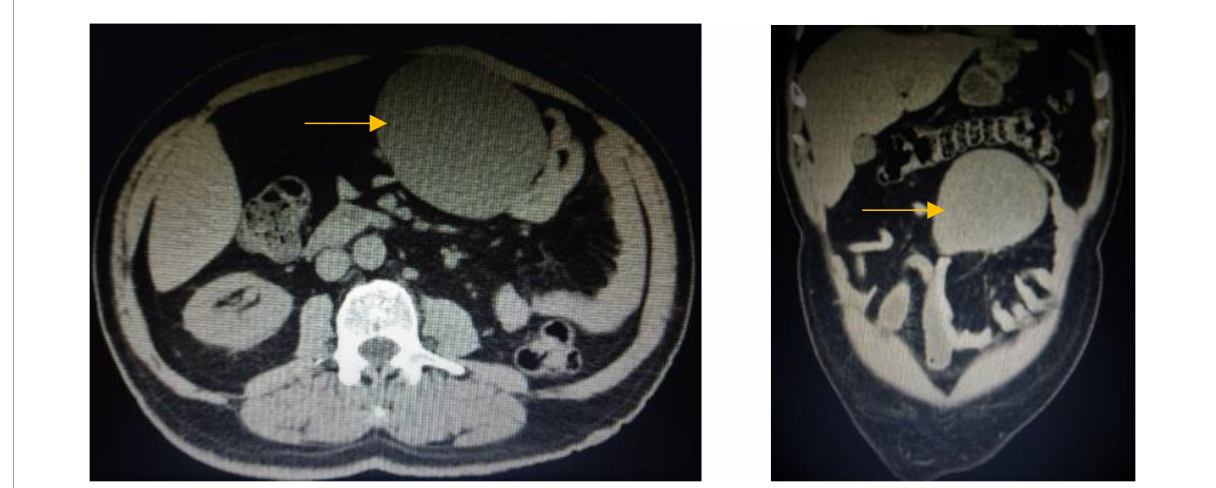
FIGURE1 CT scan of the abdomen, coronal, and axial images shows large well-defined opacity at mesentery on the left side of the upper abdomen surrounded by small and large bowel loops with no enlarged mesenteric or retroperitoneal lymph nodes.